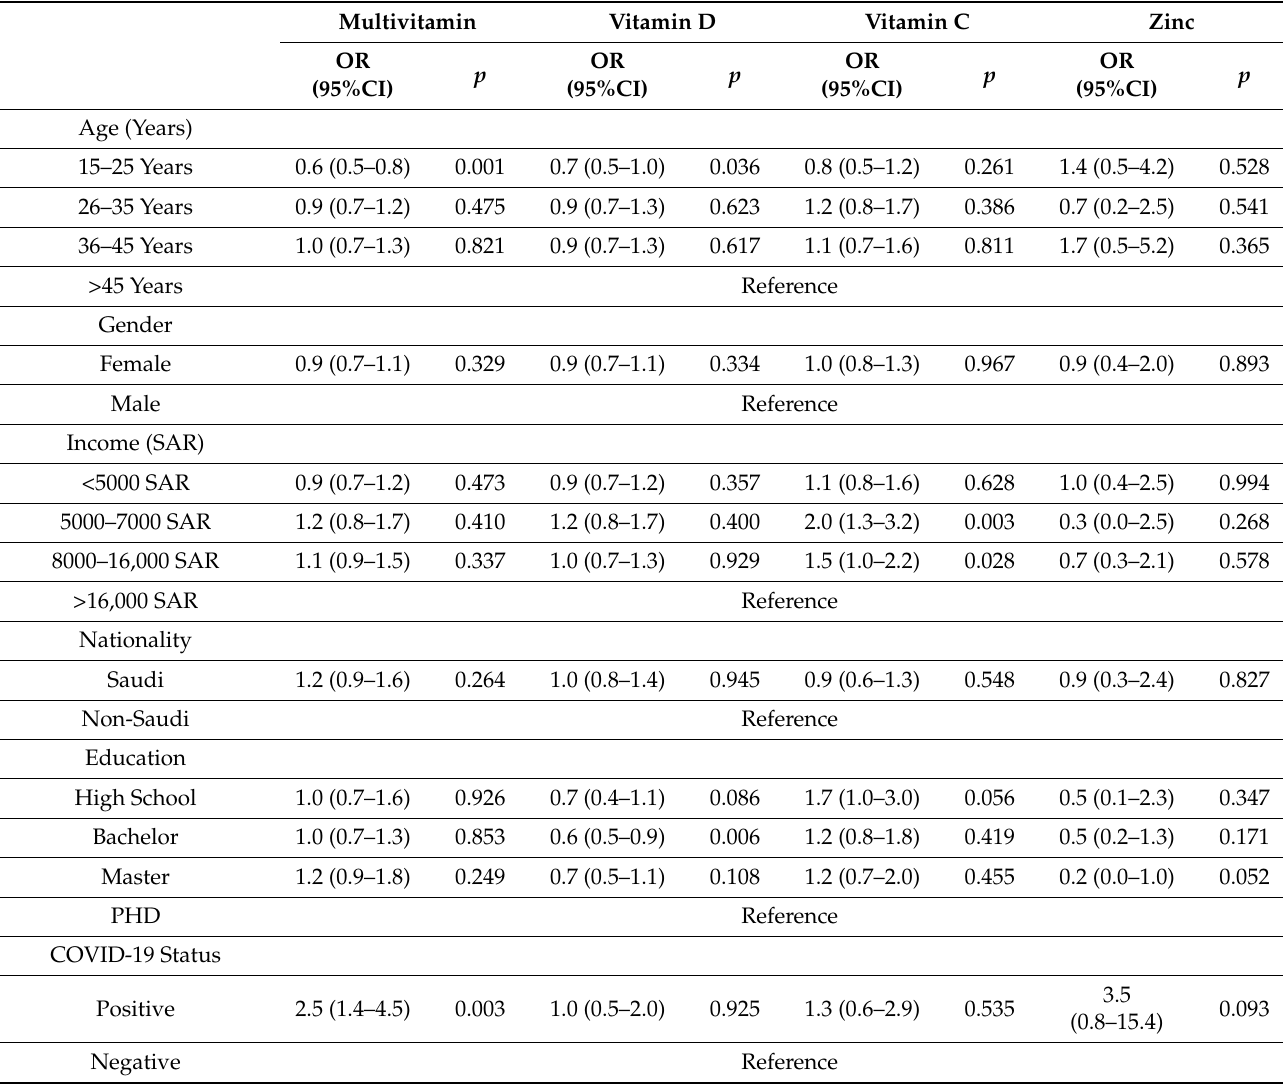
Table 4. Odds ratios for dietary supplement use according to socio-demographics and COVID-19 status. Multivitamin Vitamin D Vitamin C